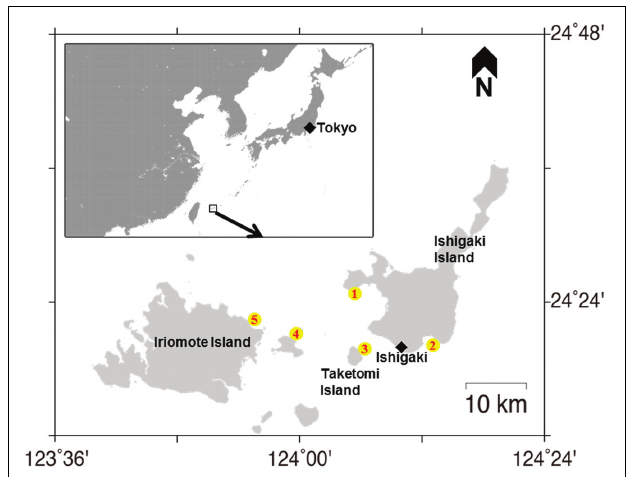
FIGURE 1 | Map showing the sampling locations. Sites are marked with a yellow circle. (1) Osaki; (2) Miyara; (3) Taketomi; (4) Sekisei outer; (5) Iriomote in Ishigaki coral reef